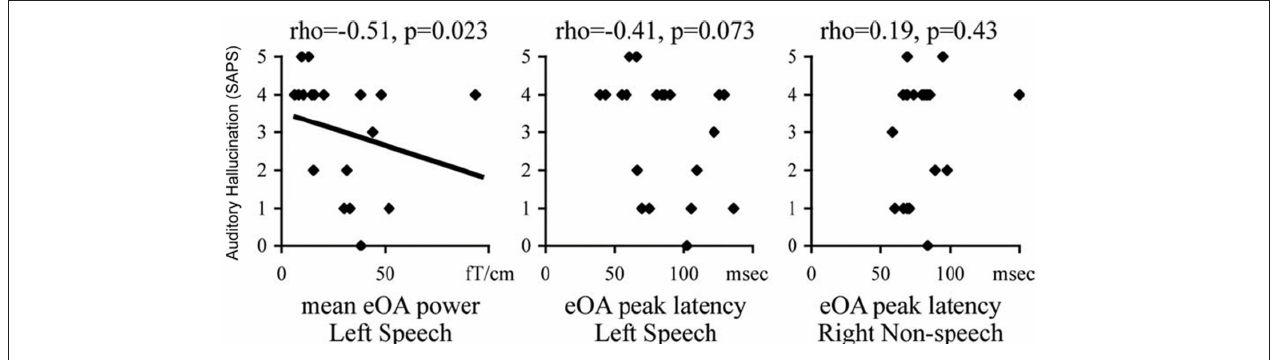
Figure  | relationship between evoked oscillatory activity (eOA) in response to speech sounds in patients with schizophrenia to auditory hallucination scores as measured through SAPS. During the period of 100– 150 ms following a speech sound, the magnitude of the eOA was negatively